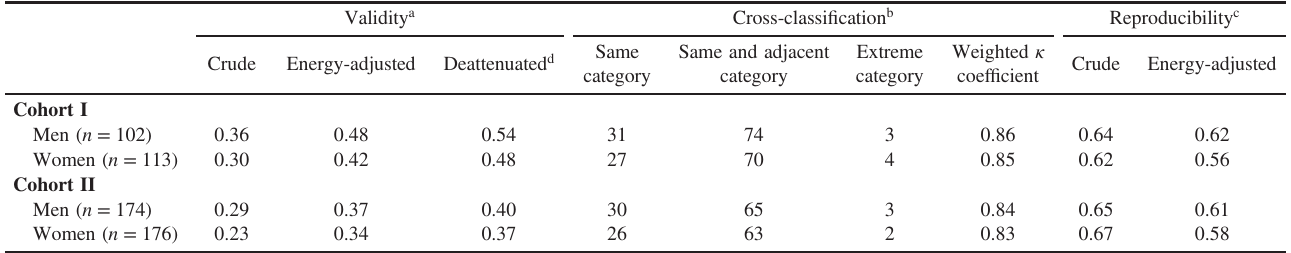
Table 2. Evaluation of the relationship between DR and FFQ_V and between FFQs by correlation and cross-classi fi cation analysis Validity a